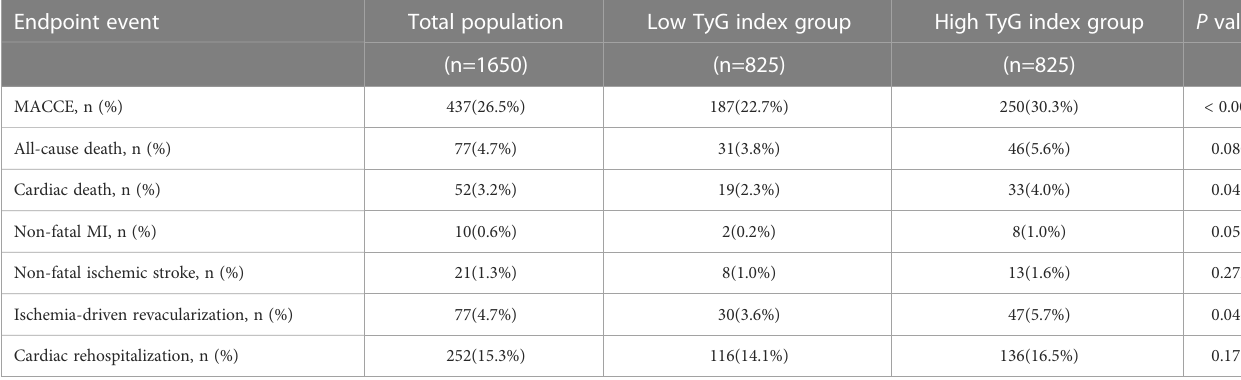
TABLE 2 Incidence of MACCE in low and high TyG index